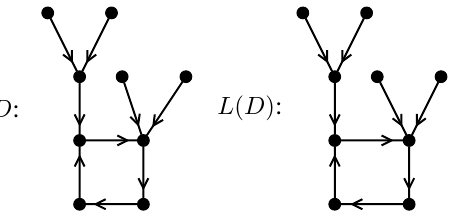
Figure 4: A digraph isomorphic to its line digraph.